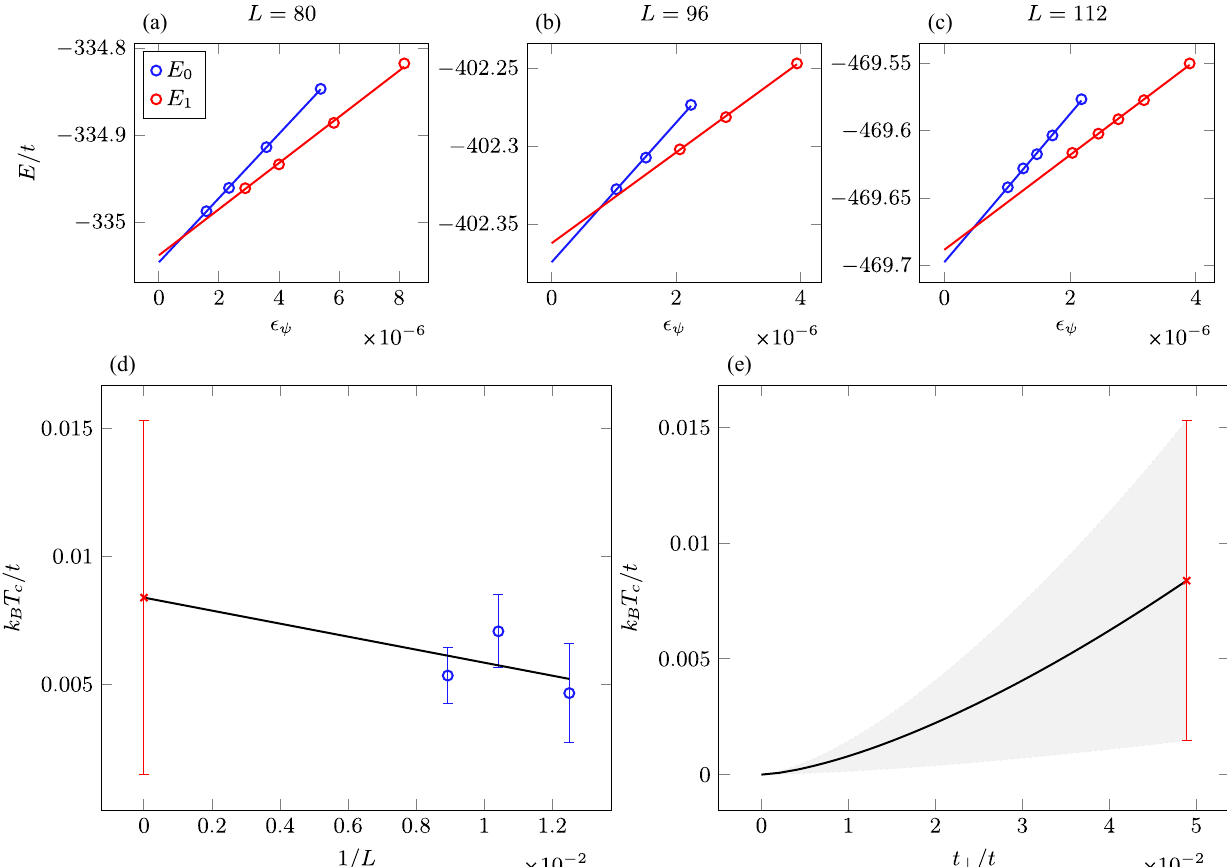
FIG. 13. Energy gap to the first excited state and critical temperature of the Hubbard ladder for U ¼ 8 t , n ¼ 0 . 9375 , t ⊥ ¼ 0 . 0489 t , and MF terms with range r ¼ 3 . The panels show ground-state energy E 0 (blue circles) and excited-state energy E 1 (red circles) plotted against their truncation error ϵ ψ and extrapolated to zero truncation error (blue and red lines) for a ladder with length (a) L ¼ 80 , (b) L ¼ 96 , (c) L ¼ 112 . While E 1 ð ϵ ψ Þ > E 0 ð ϵ ψ Þ can happen, this comparison is meaningless, as only energies at the same χ can be compared (cf. main text), where we always find E 0 ð χ Þ < E 1 ð χ Þ . Continuing, (d) shows the critical temperature of the 3D ladder array Δ =R 0 . 77 T K ρ E 1 − E 0 =R K ρ K ρ extrapolated to infinite size where R is given by Eq. (46) and K ρ c ¼ ; þ Þ ¼ ½ ; þ Þ(cid:3) ; þ Þ ; þ ¼ ladder ð ladder ð ladder ð [6], while (e) shows the critical temperature vs t ⊥ exploiting the scaling known from Eq. (F4), using the T value obtained c in (d) (red